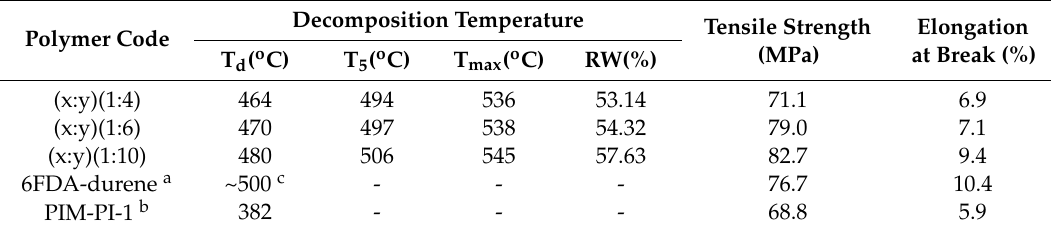
Table 4. Thermal and mechanical properties of the [(PIM-PI) x -(6FDA-durene-PI) y ] copolymers, 6FDA-durene PI and PIM-PI-1 homopolymer and their corresponding membranes. Decomposition Temperature Tensile Strength Polymer Code